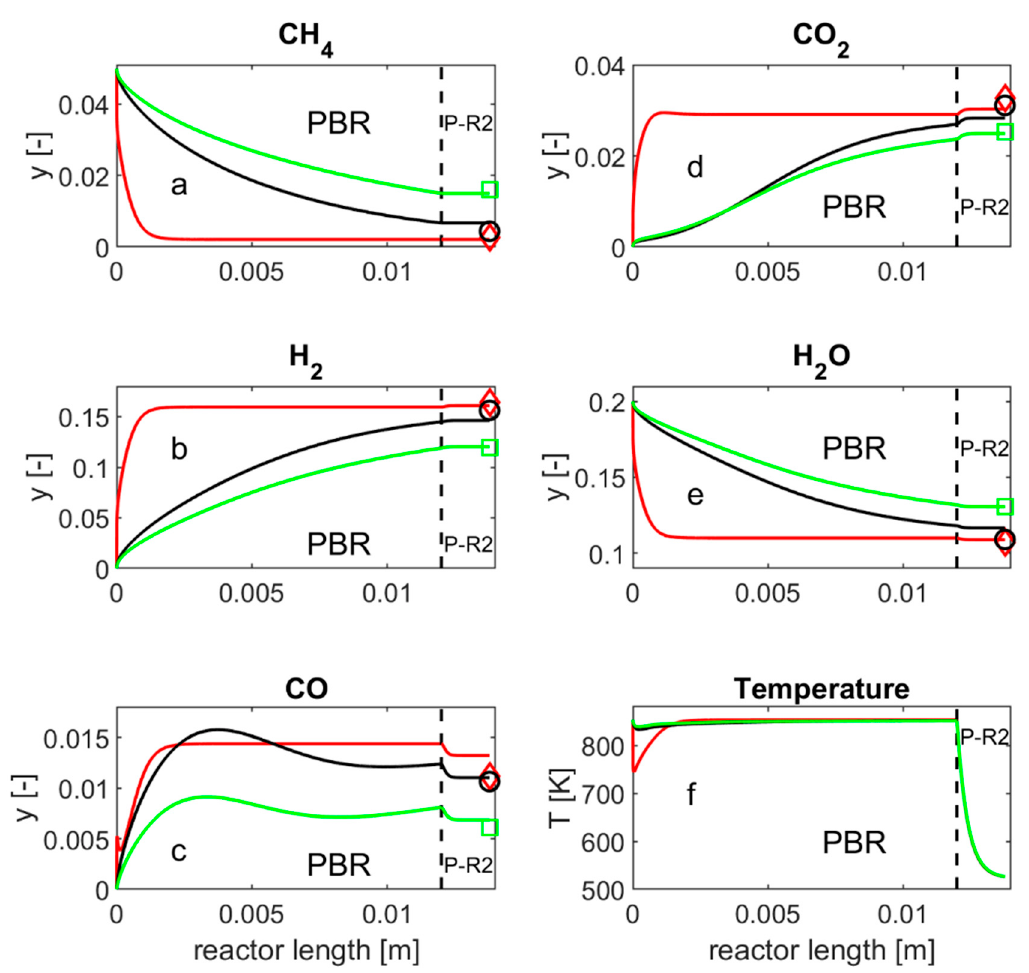
Figure 3. Results for the MCO2 operating mode (gas hourly space velocity (GHSV) = 6.7 × 10 3 h − 1 ), furnace temperature 623 K. ( a ) CH 4 ; ( b ) H 2 ; ( c ) CO; ( d ) CO 2 ; ( e )H 2 O; and ( f ) temperature. Simulation results are reported only for the catalytic section (PBR) of the reactor. Lines: simulations. Symbols: experimental data (at the sampling point). Catalysts: 25-4Q.